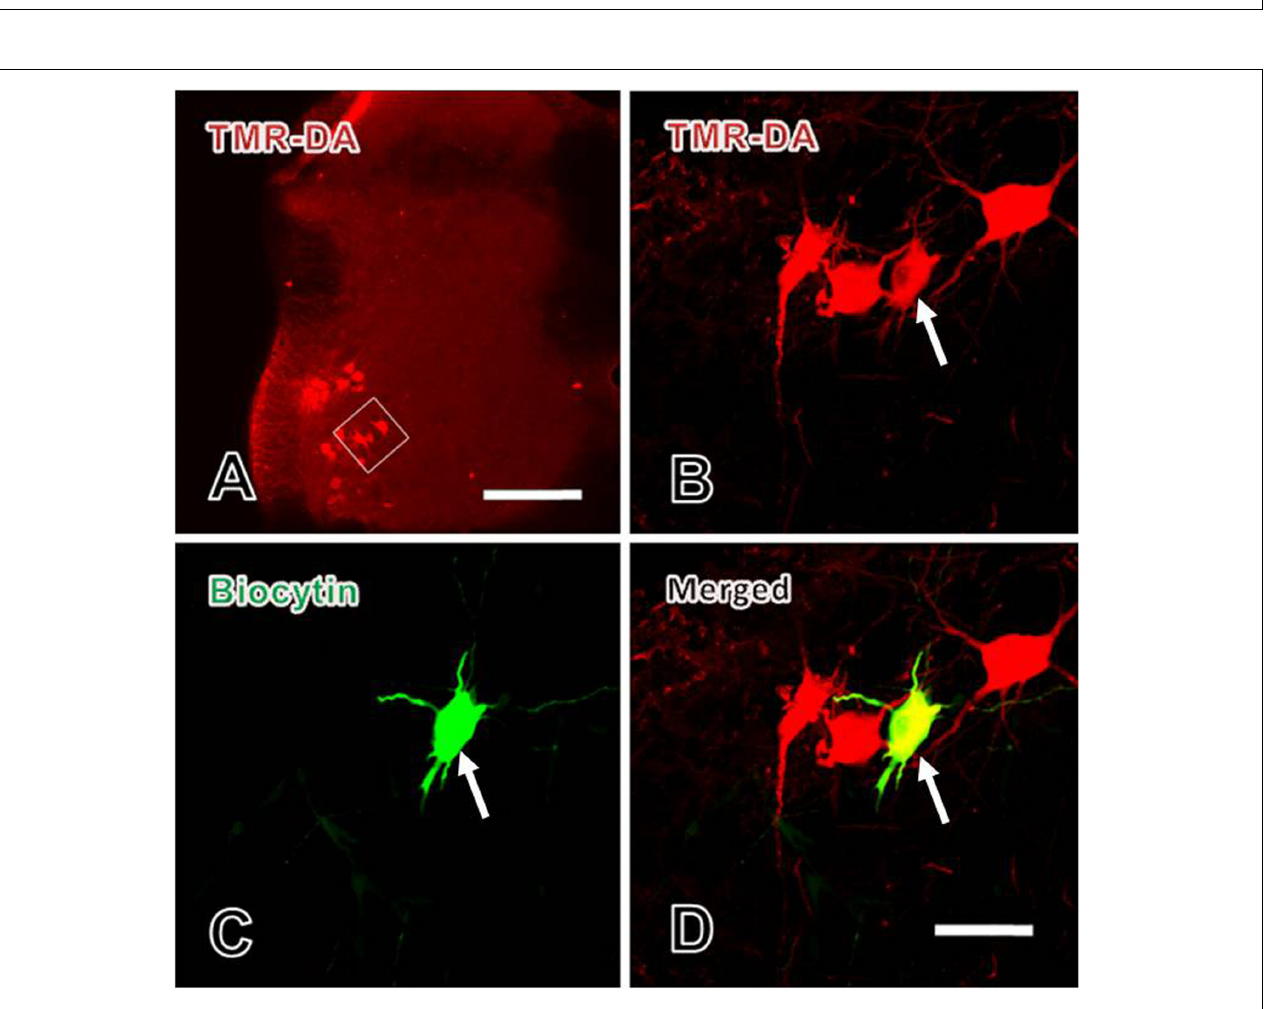
FIGURE 4 | Verification of the patch-clamp recorded neurons in spinal ventral horn. (A) The lower power image of TMR-DA labeled motoneuron (red) in lamina IX of spinal ventral horn in which TMR-DA was injected into the sciatic nerve. The white rectangle in (A) was magnified in (B) . (B–D) The higher power images of the TMR-DA labeled motoneuron (red in B ) also showed biocytin positive labeling (green in C ), i.e., the TMR-DA/biocytin double labeled motoneuron (yellow in D , indicated with white arrows) in lamina IX of the spinal ventral horn. Scale bars = 200 µ m in (A) , 25 µ m in (B–D) .